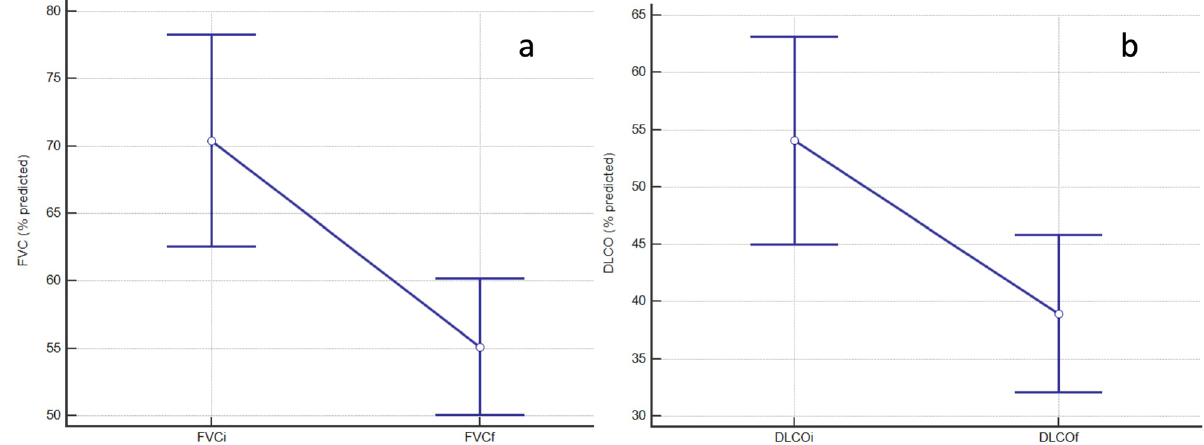
Figure 3. Respiratory functional impairment in deceased patients. FVC (%) impairment is represented in the graph ( a ) and DLCO (%) impairment is represented in the graph ( b